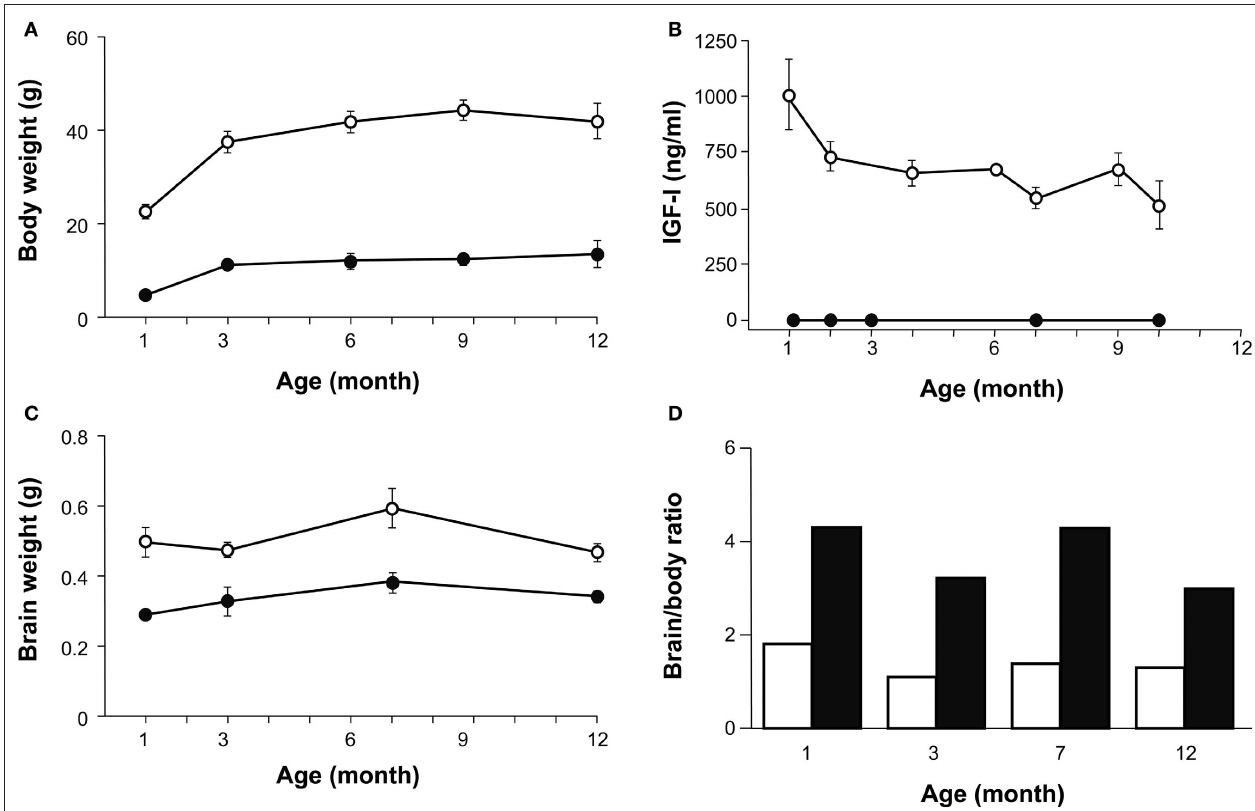
could be detected at any time in the null mice (closed circles). Data are given in ng/ml as median ± s.e.m. At least six to eight mice were studied per group. (C) Brain weight measurements did not change significantly as the mice aged, although there was a significant difference between the two genotypes at the ages studied ( P < 0.05). (D) The brain/body weight ratio was calculated for each age group of Igf1 + / + wild type (black bars) and Igf1 − / − null mice (white bars). This ratio did not vary with age in any genotype. The number ( n ) of mice studied in (A) , (C) and (D) were 19, 7, 9, 8 and 5 wild type and 8, 6, 7, 6 and 5 null mice of 1, 3, 6, 9 and 12 month old,